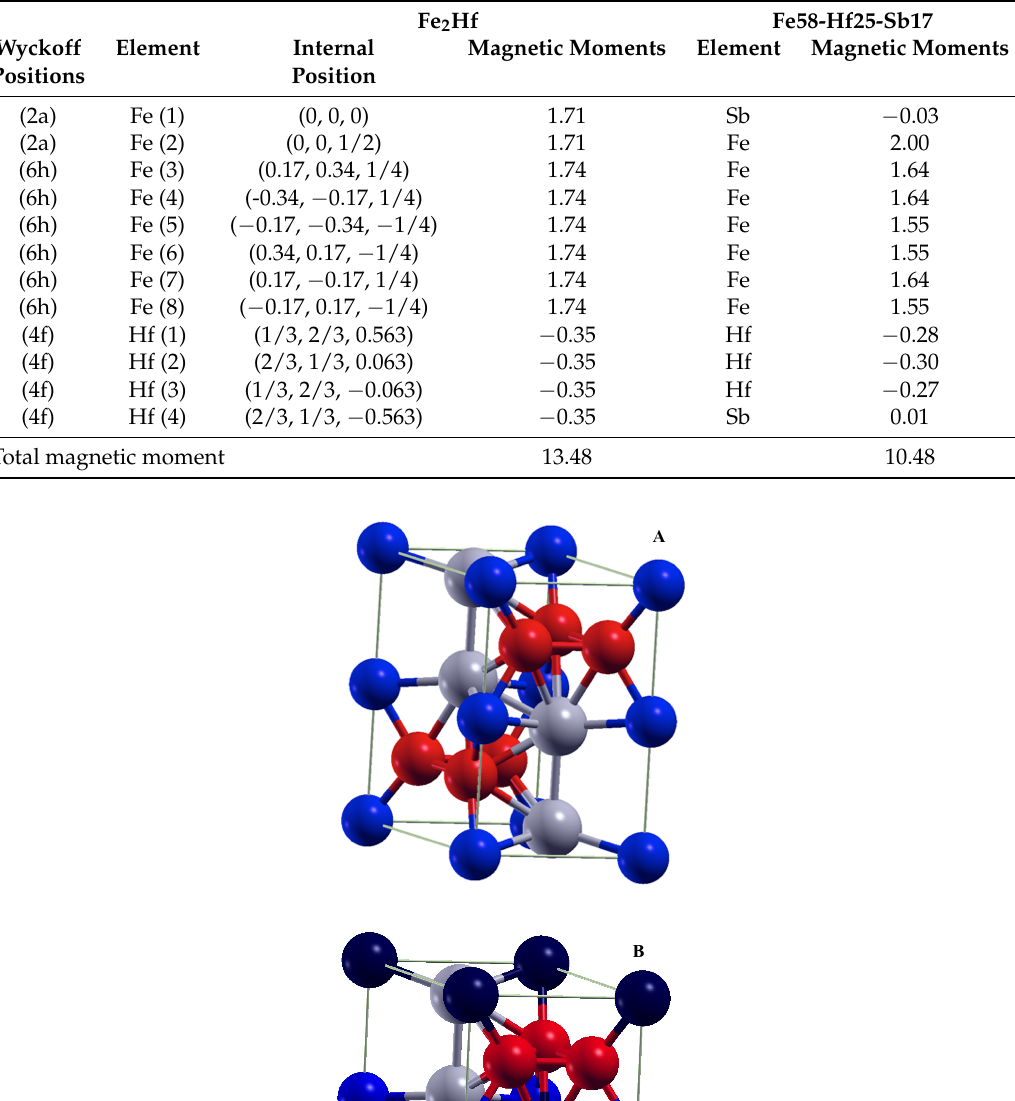
Table 1. The calculated magnetic moments (in µ B ) inside the MT-spheres of different atoms in pristine Fe 2 Hf and Fe58-Hf25-Sb17 alloy unit cell, together with the total magnetic moment per cell. The Wyckoff positions and internal coordinates of different atoms in the unit cell are shown.